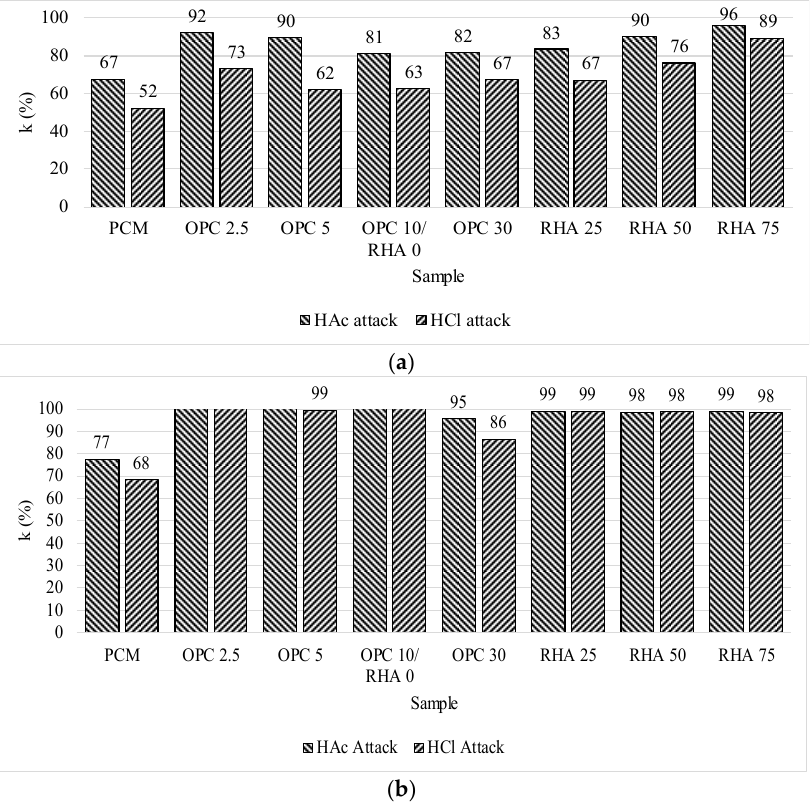
Figure 6. Resistance to acid attack: ( a ) Flexural strength; ( b ) Compressive strength. K value (%): K = ((Resistance at 28 days-Resistance after cycle)/Resistance at 28 days) × 100.